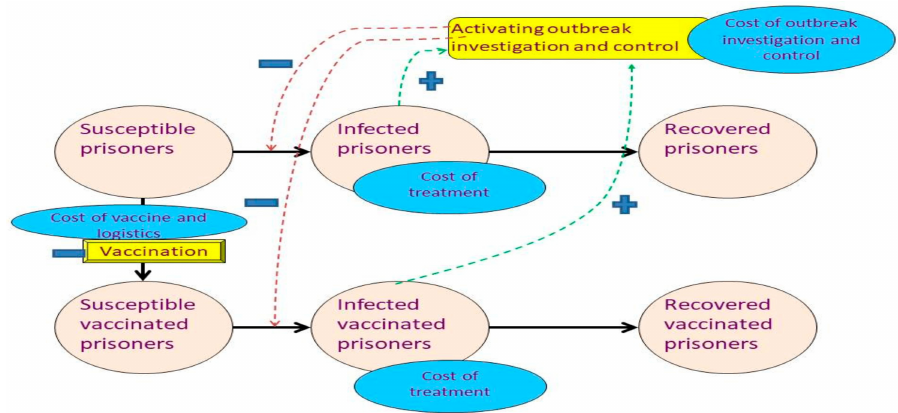
Figure 1. Brief framework of the model. Note: ( + ) = activating or accelerating the transition; ( − ) = deactivating or decelerating the